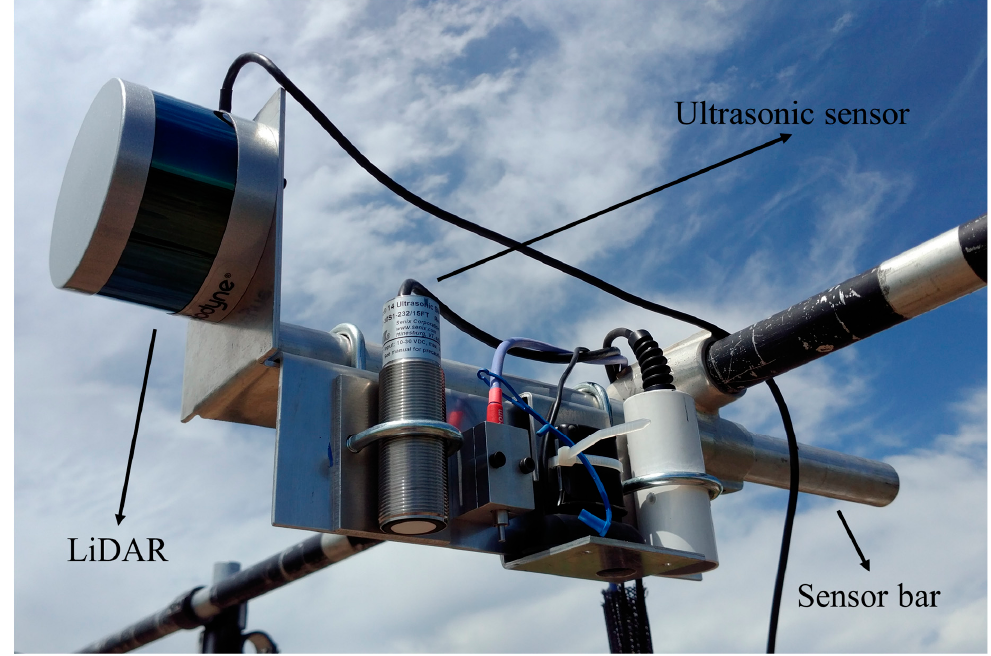
Figure 1. Light detection and ranging (LiDAR) and ultrasonic sensor of the ground phenotyping